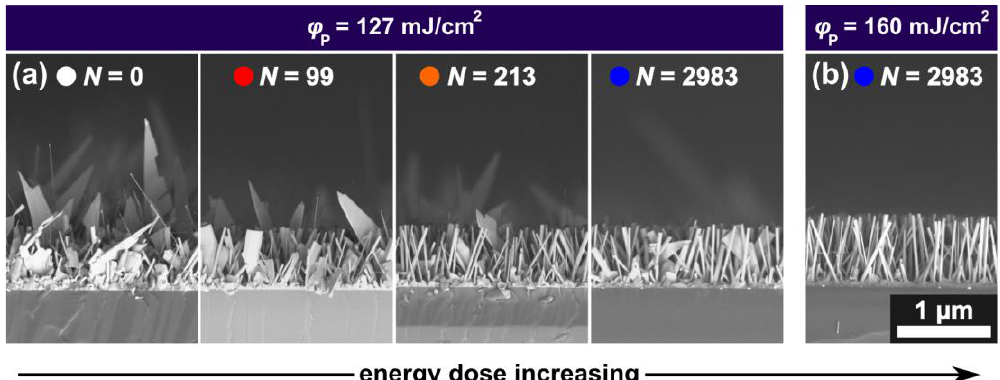
Figure 8. ( a , b ) Equivalent radius r(eq.) (black) and area particle density ρ (red) of gold nanoparticles (( a ) pNPs, ( b ) eNPs) after laser irradiation and thermal treatment (925 °C). ( c ) Width (black) and height (orange) of ZnO-NRs. ( d ) Electron microscopic images (cross-sections) of ZnO-NRs generated with different effective pulse numbers N . ( 𝜑 𝑝 = 160 mJ/cm 2 , t = 10 min, T = 925 °C).